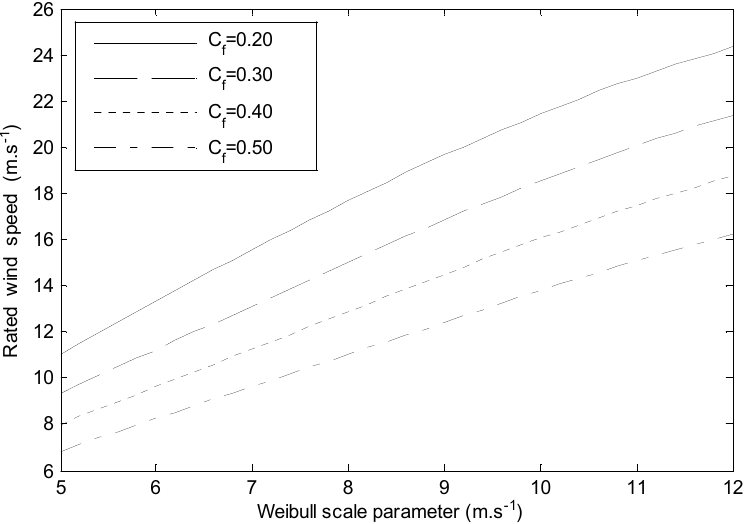
Figure 3. Variation of rated wind speed with scale parameter for different value of turbine capacity